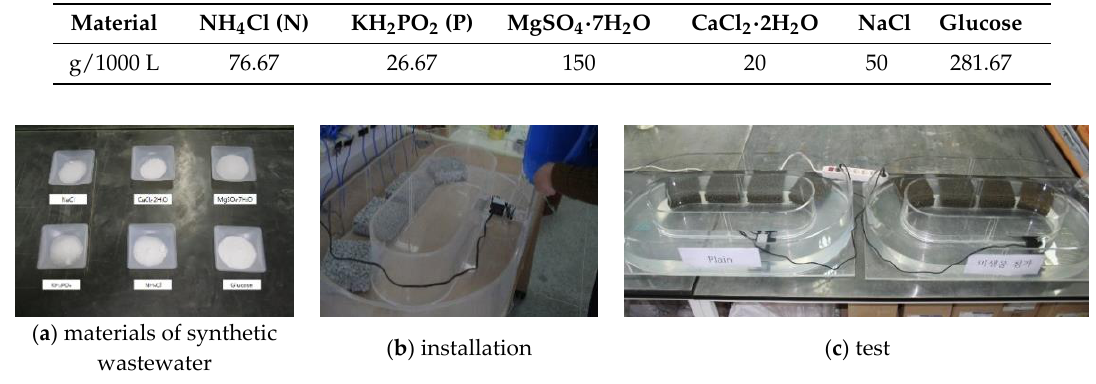
Table 7. Mix proportion of synthetic wastewater.